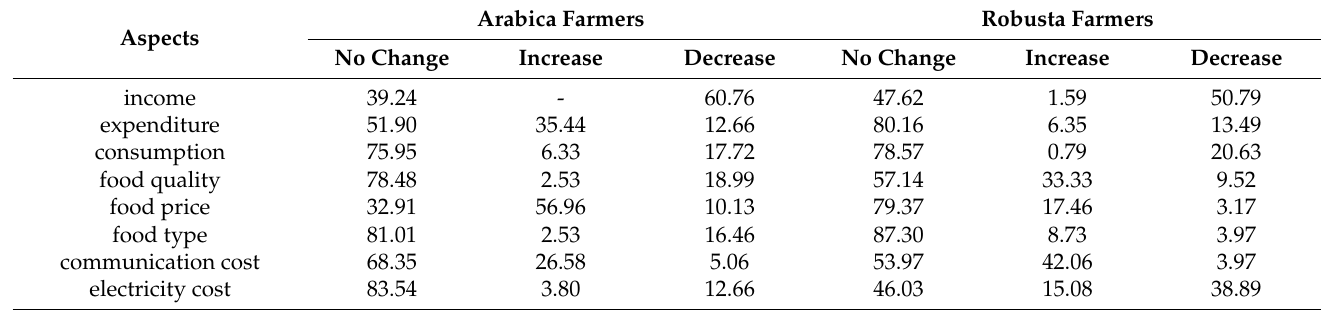
Table 4. The proportion of coffee farmers who experienced changes as a result of COVID-19 (in